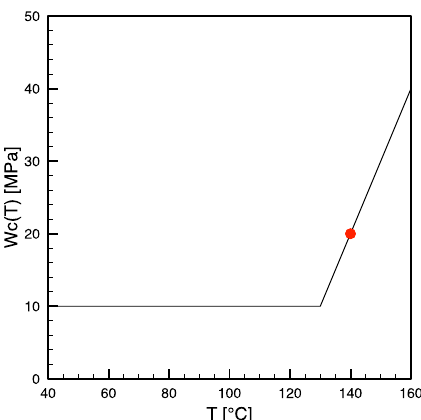
Figure 8. Critical work as function of temperature adopted for the results of simulations reported in Figure 7; the red dot represents the experimental results at 140 °C obtained using the iPP T30G adopted for the injection molding tests considered in this paper.